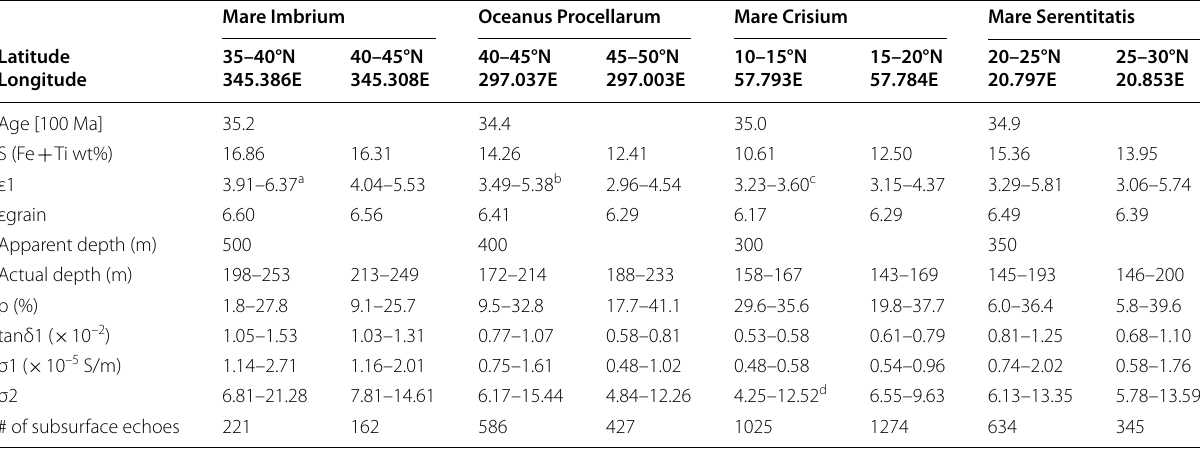
Table 1 Summary of the data